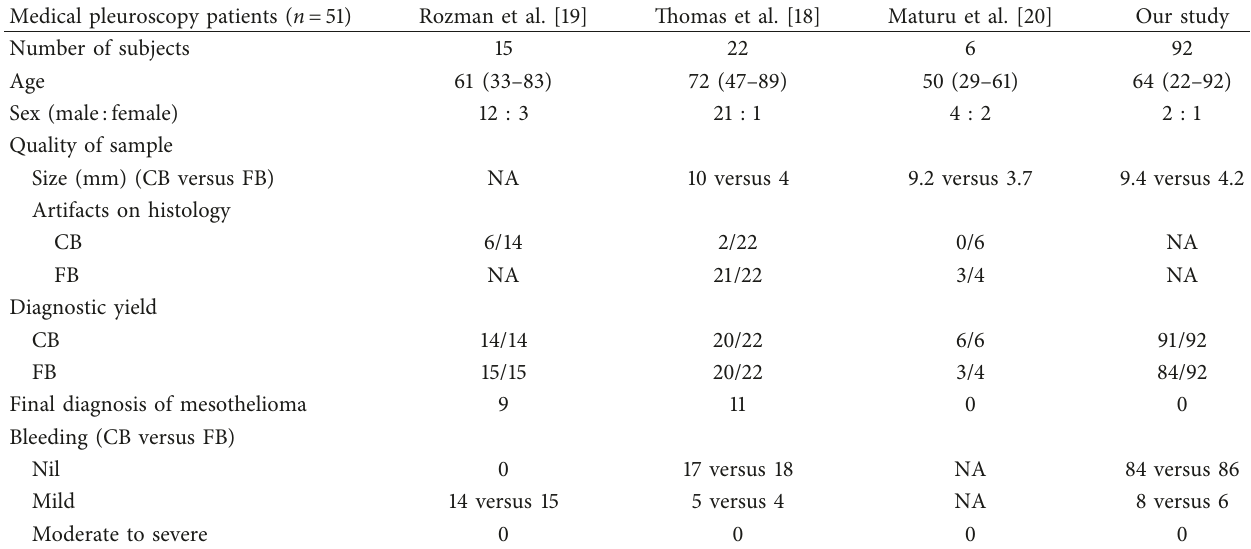
Table 4: Comparison with similar